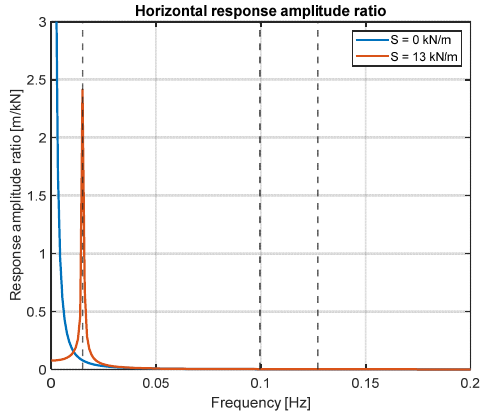
Figure 17. Case 1, Minimum diameter, pre-tension 30 kN.